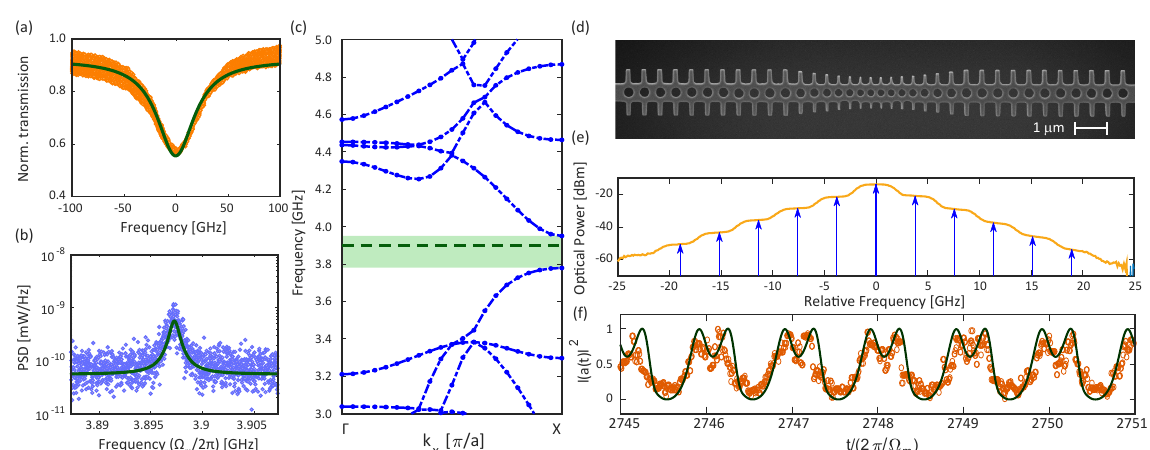
Figure 1. (a) Optical experimental resonance trace (purple) and Lorenztian fit (dark line). (b) Power spectral density of the mechanical resonance confined in the total bandgap. (c) Phononic band diagram for the real profile mirror unit cell extracted from the SEM image, including the experimental measured frequency of the mechanical mode (dashed line). (d) SEM image of the fabricated OM cavity. (e) Recorded optical spectrum in purple showing a set of peaks corresponding to di ff erent harmonics represented in blue at the expected position. (f) Comparison of the experimental (dots) and the theoretical (solid line) temporal OM-generated OFC traces.